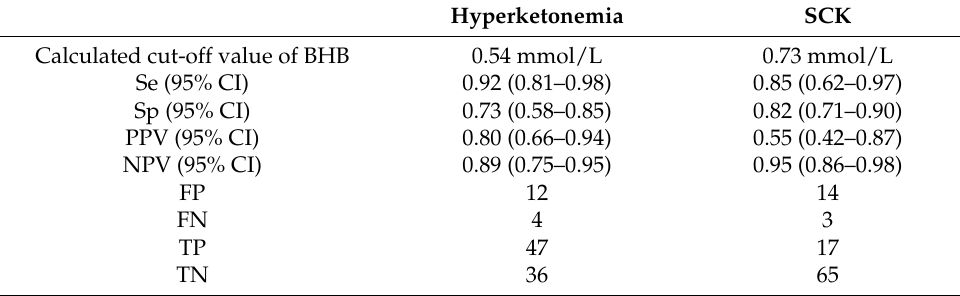
Table 1. Summary of parameters for the calculated cut-off value for hyperketonemia and subclinical ketosis (SCK). The optimal criterion represents the cut-off value resulting in zero false negative cases. BHB: beta-hydroxybutyrate; CI: confidence interval; Se: sensitivity; Sp: specificity; PPV: positive predicted value; NPV: negative predicted value; FP: false positive; FN: false negative; TP: